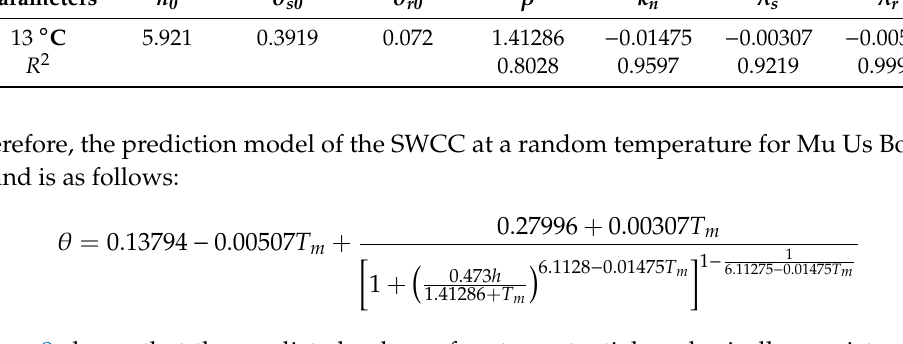
Table 4. Fitting parameters for an soil-water characteristic curve (SWCC) model based on the VG model.